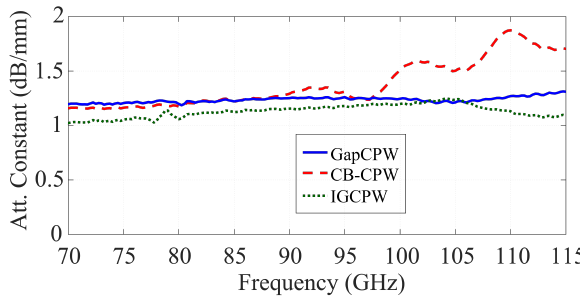
Figure 18. Extracted attenuation